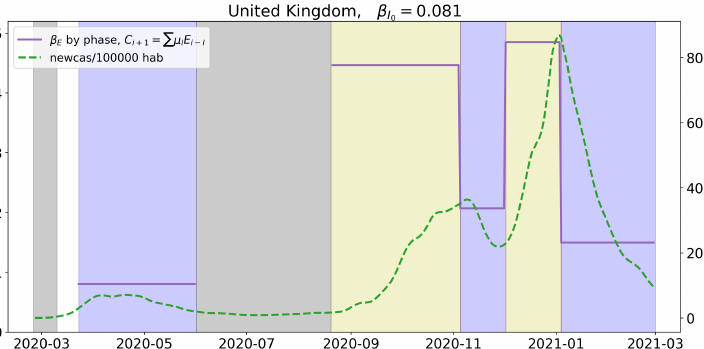
Figure 10. Value of β E for the different levels of lockdown. Blue will correspond to Stage 1, yellow to Stage 3 and white to Stage 4. A green dotted line corresponds to the value of new cases per 100,000 hab.